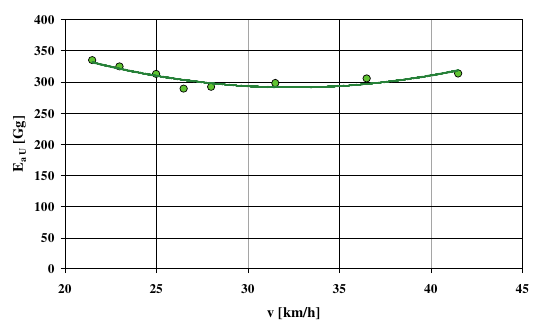
Fig. 1. Dependence of the national annual emission of carbon monoxide from passenger cars upon the average velocity, under model conditions of urban traffic